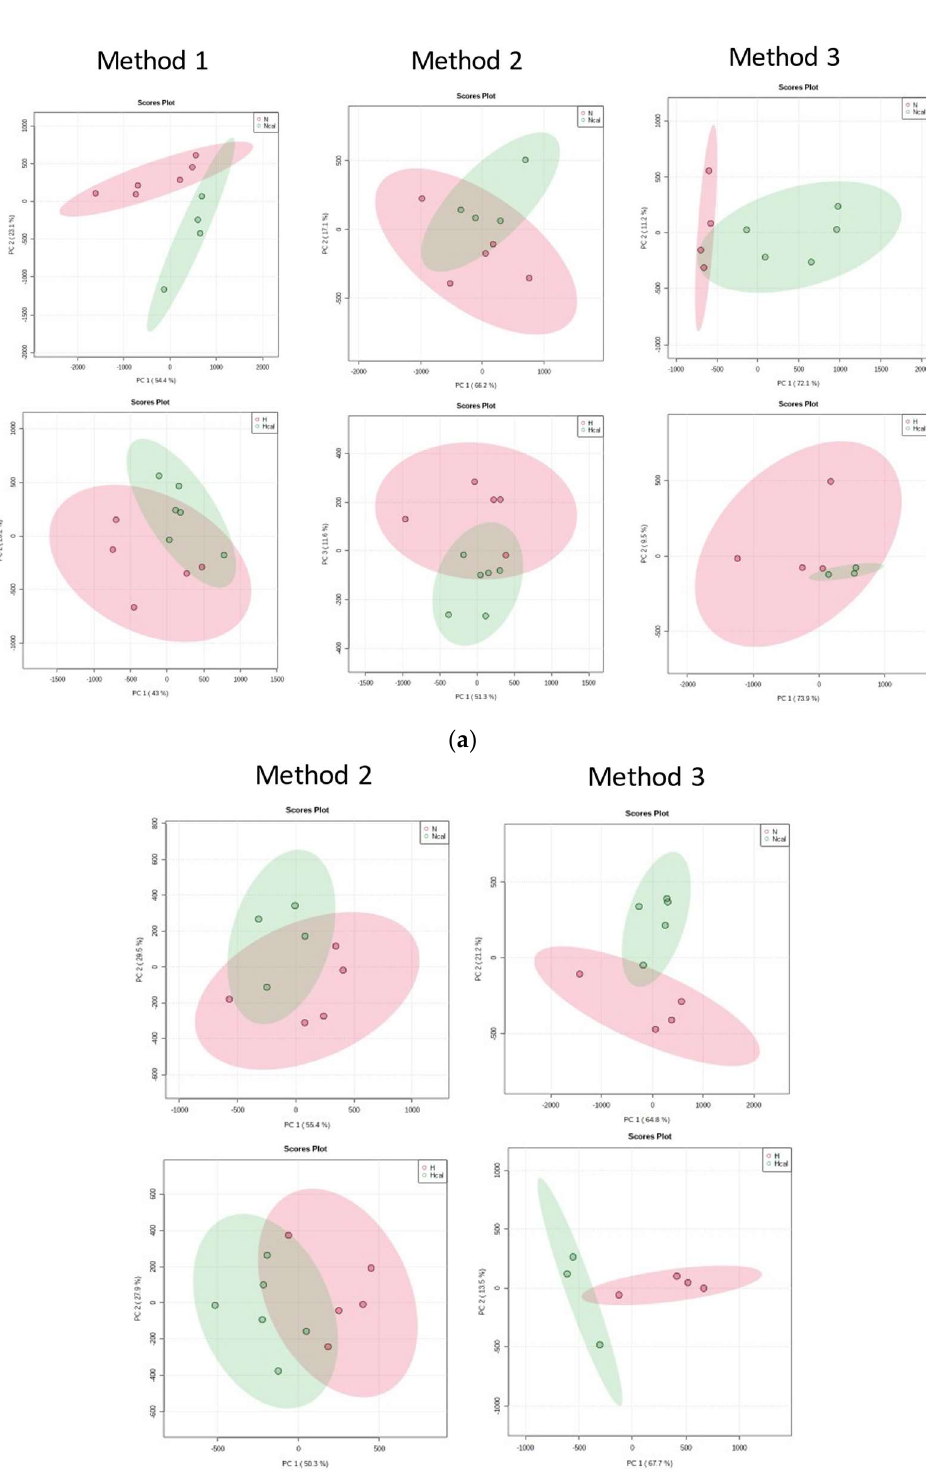
Figure 2. Principal component analysis (PCA). ( a ) Score plot in negative mode and ( b ) Score plot in positive mode for method 1, method 2 and method 3. N and H in red, and Ncal and Hcal in green for each ionization mode. H—High-fat diet group; N—normal diet group; Hcal—High-fat diet group with calafate; Ncal—Normal diet with calafate. Table 1. Significant metabolites identified by UHPLC-DAD-QTOF which are related with CVD (positive and negative ionization modes).